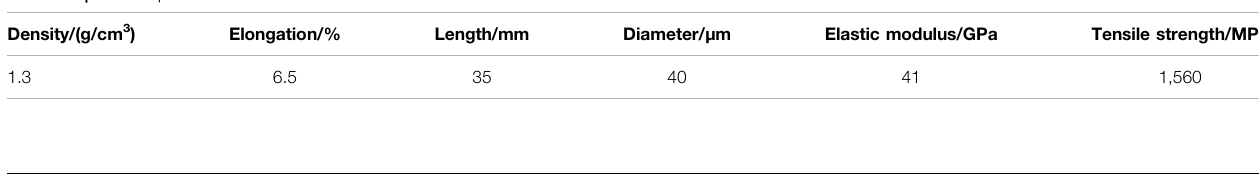
TABLE 3 | Material parameters of PVA fi bers.